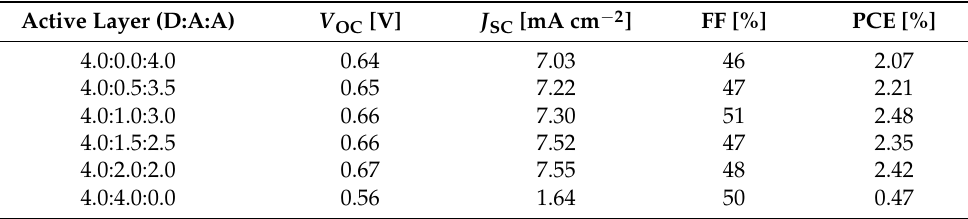
Table 3. Photovoltaic performances the P3HT: p -DPP-PhCN:PCBM devices fabricated with